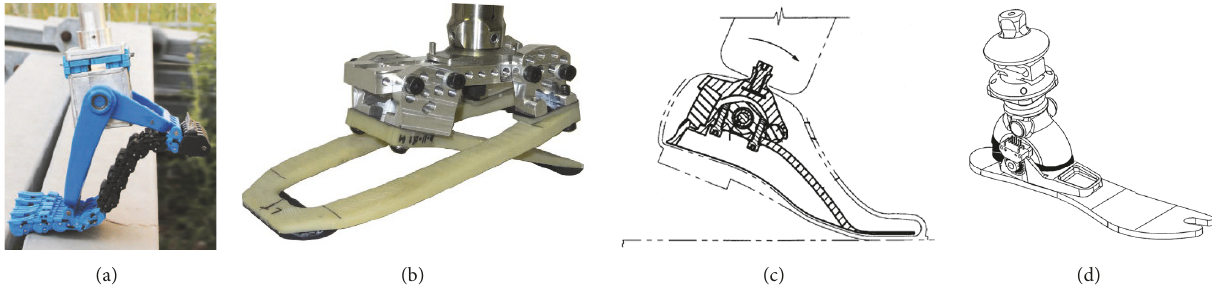
Figure 9: Passive foot prostheses. (a) SoftFoot [12]. (b) Hindfoot and forefoot stiff foot prostheses [13]. (c) One-piece mechanically differentiated prosthetic foot [14]. (d) Instrumented prosthetic foot